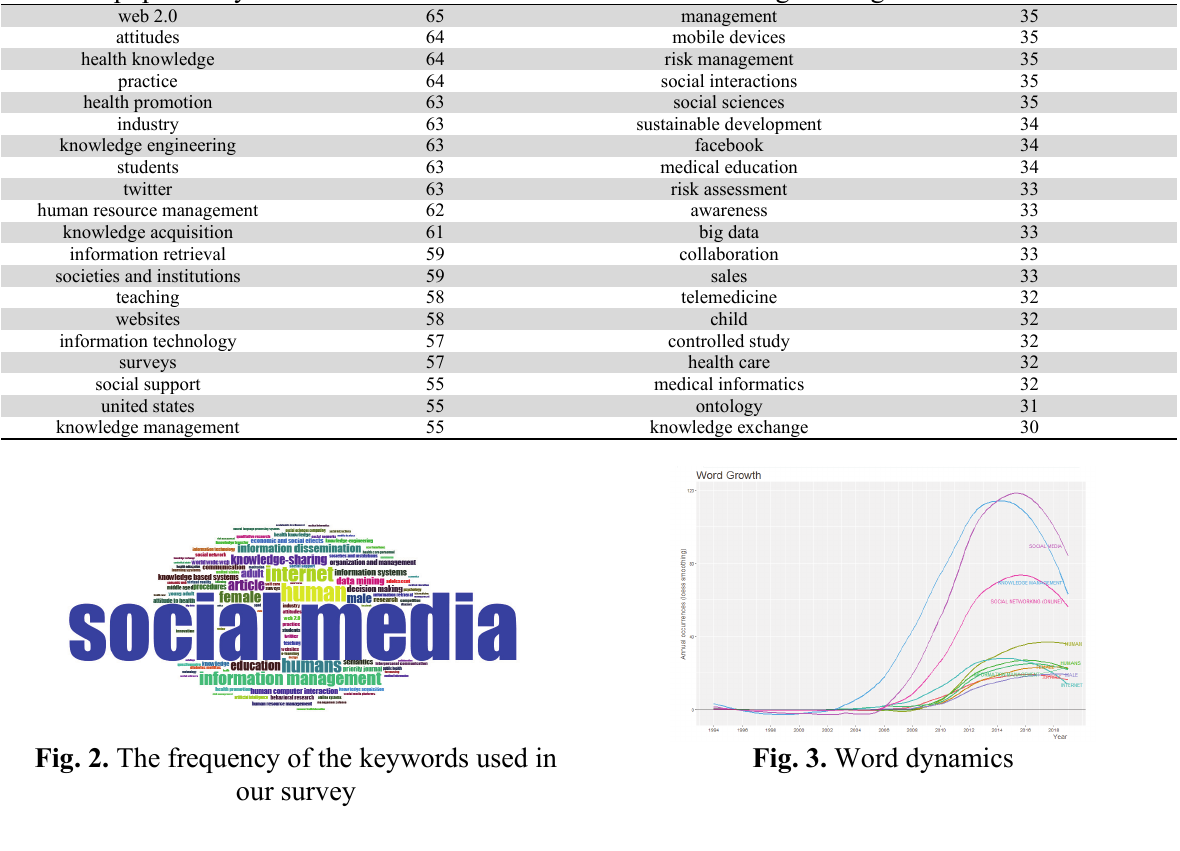
The most popular keywords used in studies associated with knowledge management and social media